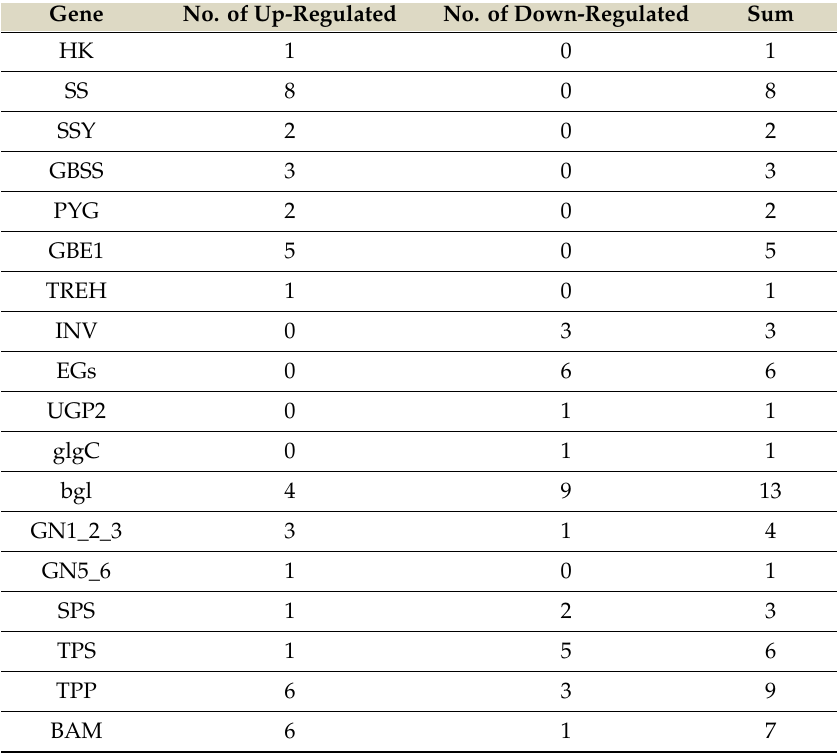
Table 7. Di ff erential expression genes related to starch and sucrose metabolism. Gene No. of Up-Regulated No. of Down-Regulated Sum HK 1